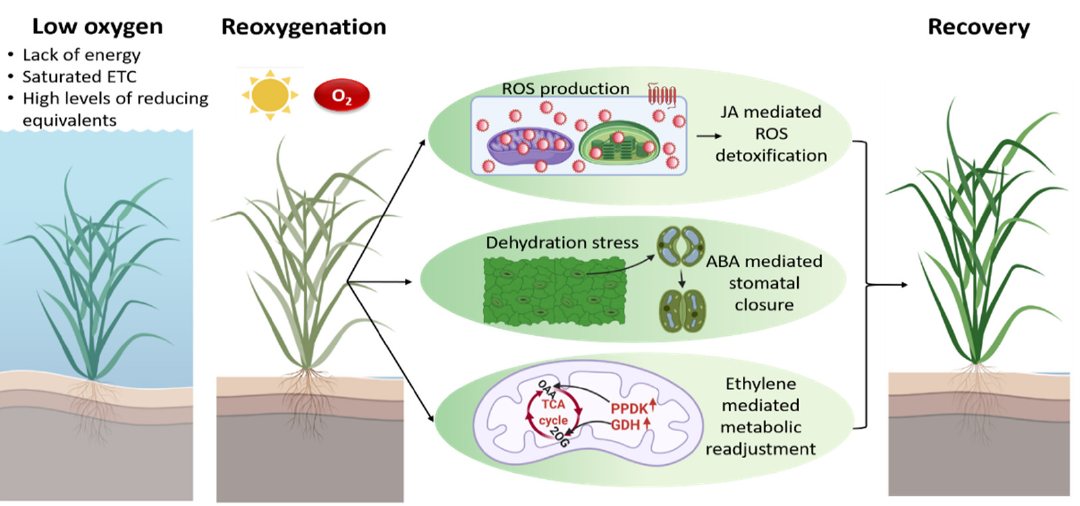
Figure 3. Under water, plants experience a shortage in O 2 that ultimately affects the mtETC. Condi- tions such as a lack of energy, saturated mtETC and high levels of reducing equivalent prevail during hypoxia. A shift to normal environmental conditions with intense light and higher O 2 after flood water retreats results in excess ROS generation in chloroplasts and mitochondria, respectively. On top of that, plants also encounter dehydration stress and an energy crisis immediately post-submergence. The re-oxygenation response is mediated via JA, ABA and ethylene signaling to counteract excess ROS generation, to overcome dehydration stress and to generate energy through metabolic readjust- ment. 2-OG, 2-oxoglutarate; GDH, glutamate dehydrogenase; OAA, oxaloacetate; PPDK, pyruvate phosphate dikinase. The figure was created using BioRender.com, accessed on 10 January